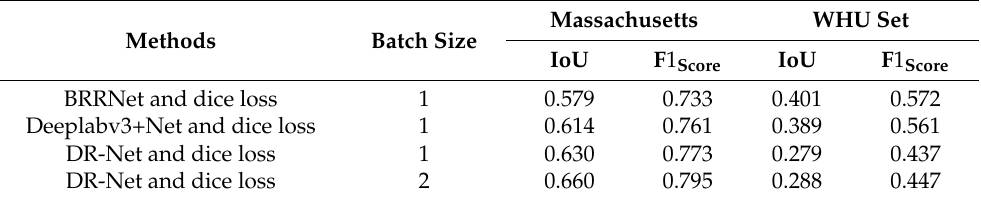
Table 6. The transfer learning of different methods (networks were trained on the Massachusetts Building Dataset). The column “Massachusetts” represents the results of the networks that were trained on the training set of the Massachusetts Building Dataset and then tested on the test set of the Massachusetts Building Dataset. The column "WHU set" represents the results of the networks that were trained on the training set of the Massachusetts Building Dataset, and then tested on the test set of WHU data set. Massachusetts WHU Methods Batch Size